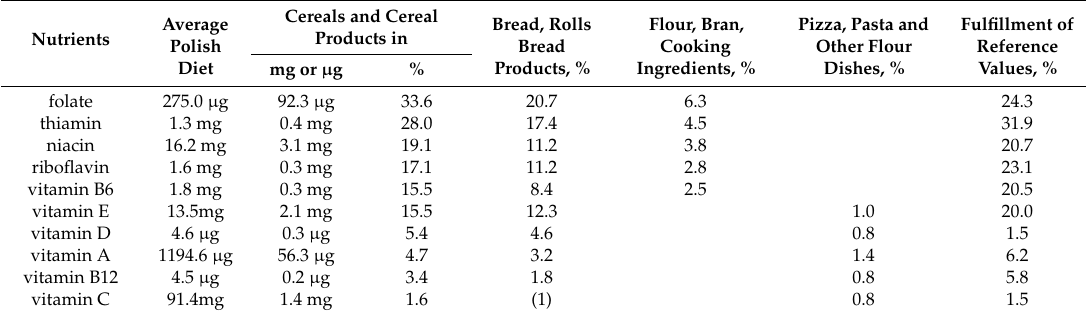
Table 6. Vitamins: contribution by cereals and cereal products to the average Polish, their top two main groups and fulfillment of the reference values.